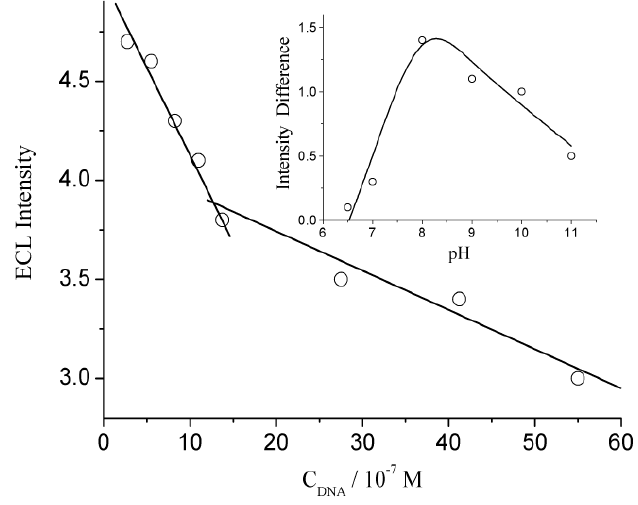
Figure 2. ECL response on bare GC electrode upon DNA content in